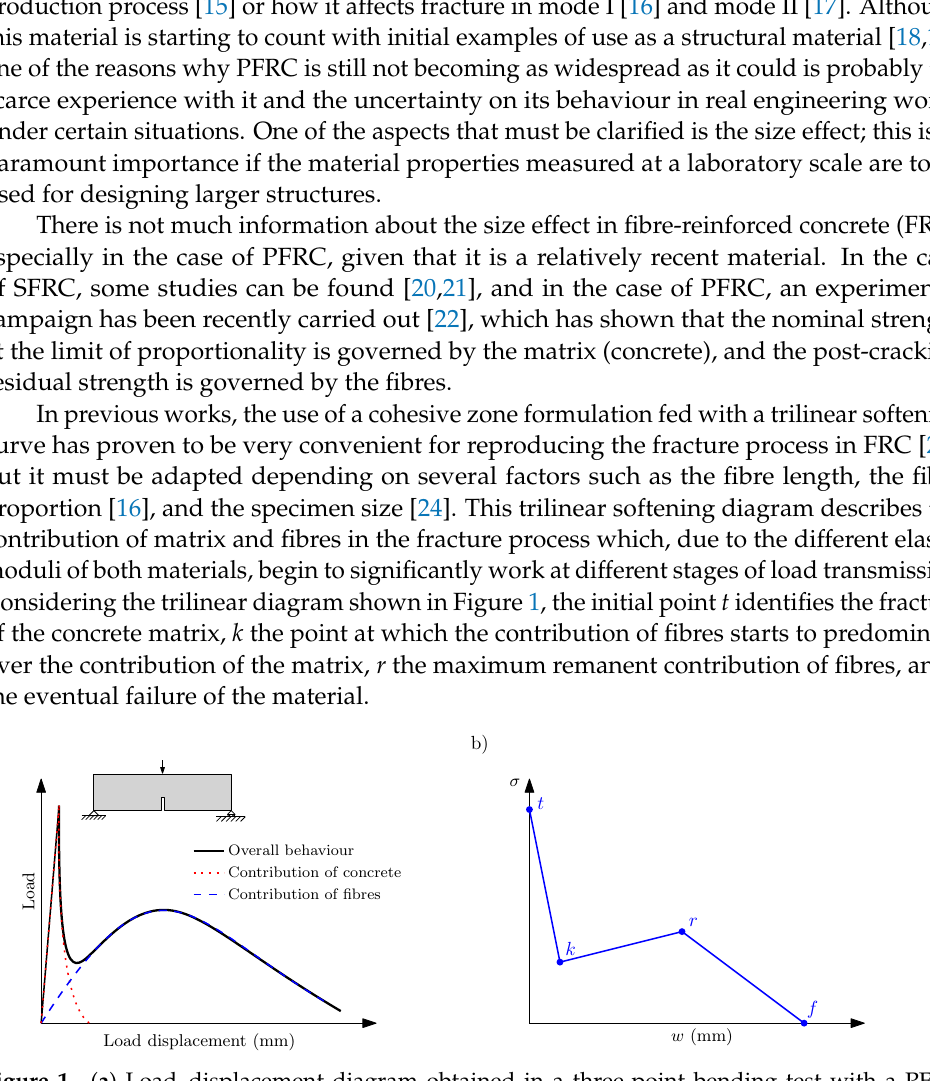
Figure 1. ( a ) Load–displacement diagram obtained in a three-point bending test with a PFRC specimen; ( b ) trilinear softening